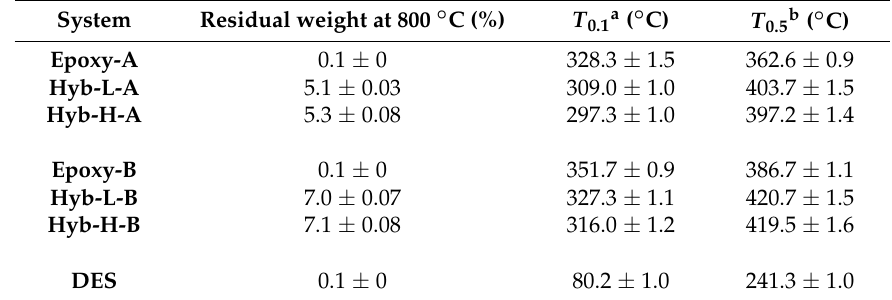
Table 3. TGA results for the neat epoxy and the hybrid epoxy-silica resins at different DES contents and curing agent